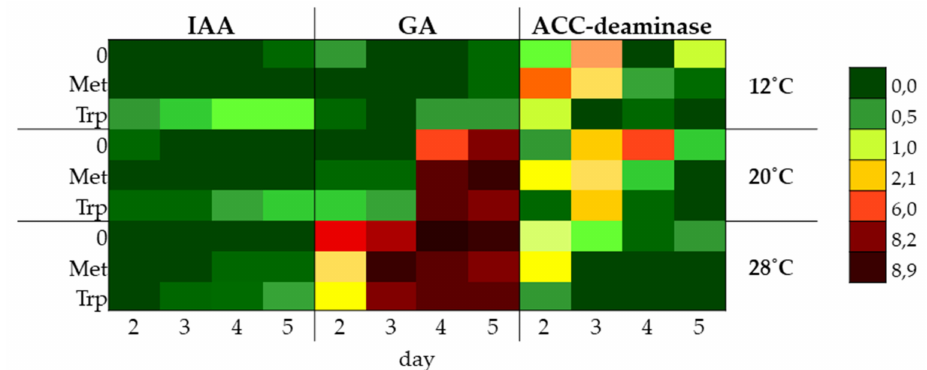
Figure 11. The heatmap allowed to compare IAA, GA concentration, and ACC-deaminase activity of Trichoderma DEMTkZ3A0strainonRBmediumwiththeadditionof3mMaminoacids(Met—methionine and Trp—tryptophan) at three temperatures 12, 20, 28 ◦ C after 2, 3, 4, 5 days of incubation. The color scheme of the heatmap fields represents the concentration in µ g / mL.